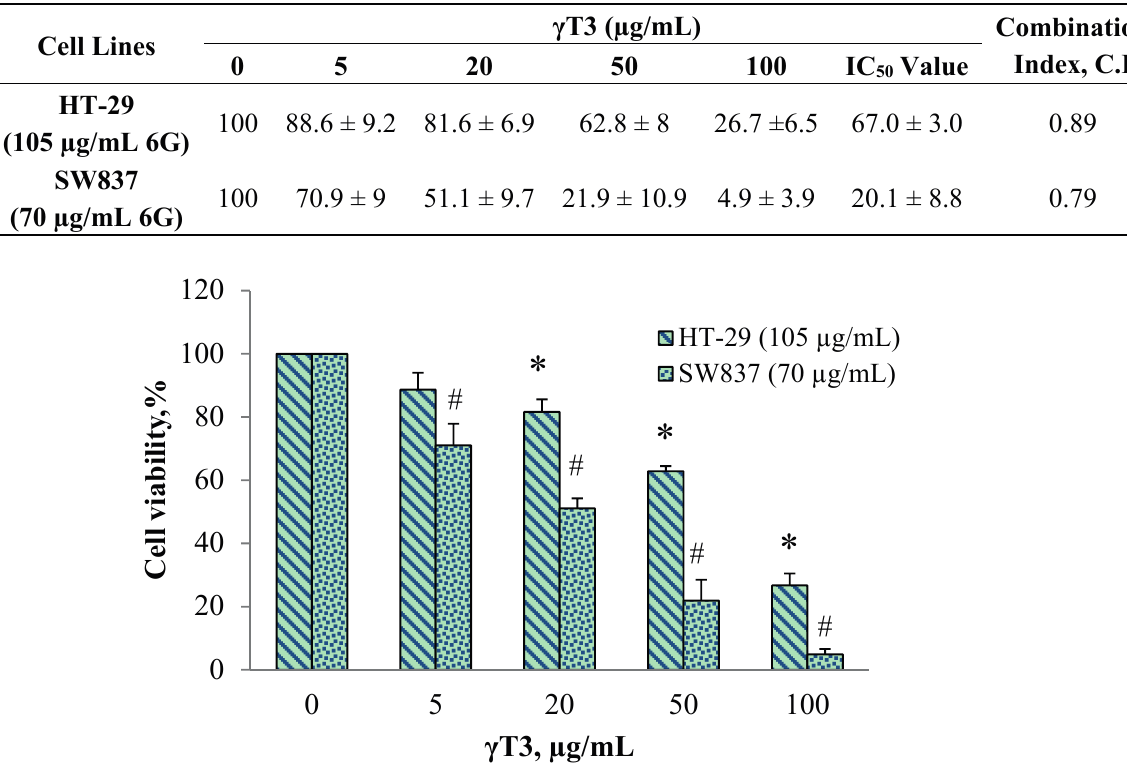
Figure 2. Cell viability assay of combined 6G and γ -T3 on cells after 24 h treatment. HT 29 cells were treated with 105 µg/mL 6G while SW 837 treated with 70 µg/mL 6G in combinations of γ -T3 (0, 5, 20, 50, and 100 µg/mL). Cell viability was measured using ELISA microplate reader at 405 nm. Values are expressed as mean ± SEM from three independent experiments ( n = 3). * Compared with untreated HT-29 cells ( p < 0.05), # compared with untreated SW 837 cells ( p <